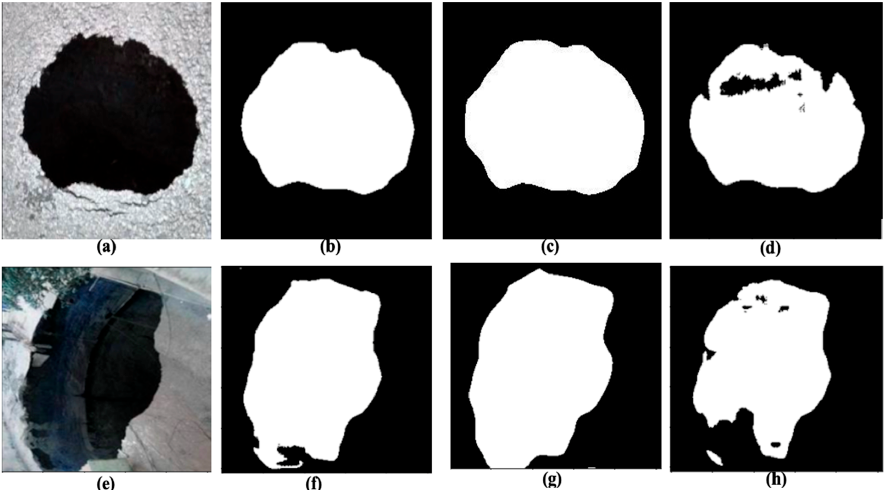
Figure 8. Two examples of the autoencoder annotation results using three different coding layer sizes: ( a ) on the first row is the original image of the first sample; and ( b – d) are the results of the autoencoder with a coding layer of size 4 × 4, 8 × 8, and 16 × 16, respectively. ( e ) On the second row is the original image of the second sample; and samples ( f – h ) are the results of the autoencoder with a coding layer of size 4 × 4, 8 × 8, and 16 × 16, respectively.